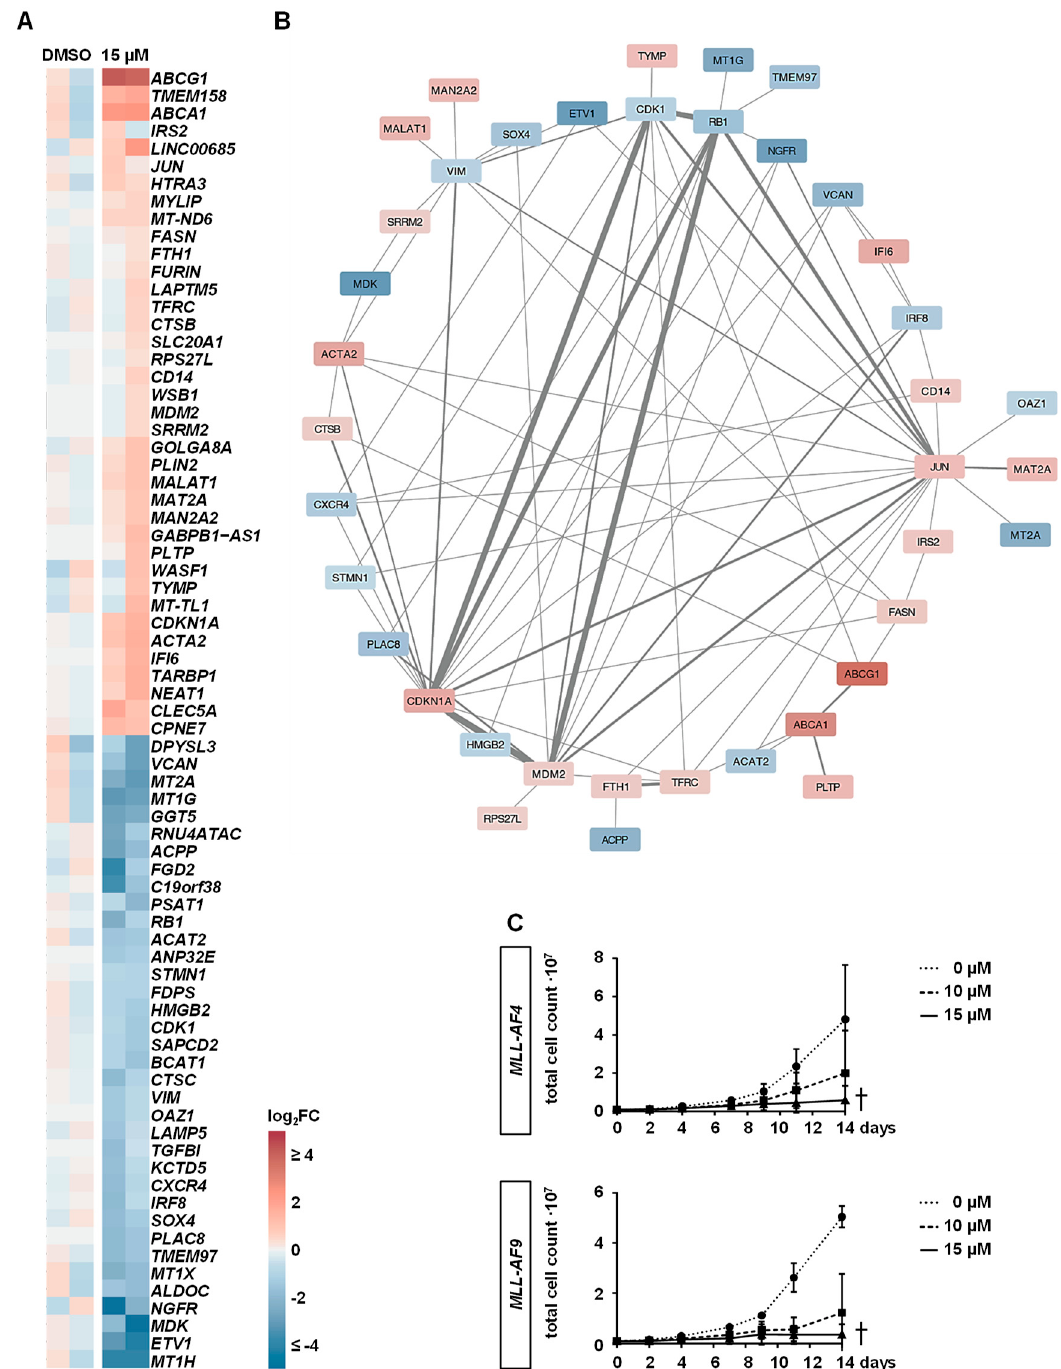
Figure 5. Downstream effects of MAT2A inhibition on gene expression. ( A ) MLL-AF4 cells were treated with 15 µM of PF-9366 or vehicle (DMSO) for 4 days and two biological replicates ( n = 2) were used for RNA-seq. DEGs are displayed with 38 genes upregulated and 36 genes downregulated. The interactome of all DEGs is shown in ( B ) with the main effect of MAT2A inhibition on cell cycle progression notable by the interacting genes CDKN1A/p21 , CDK1 , RB1 , and MDM2. ( C ) For long-term experiments, MLL-AF4/-AF9 cells were treated with 10 or 15 µM of PF-9366 or vehicle (DMSO) for a minimum of 2 weeks. Stable inhibition of proliferation is shown by two biological replicates ( n = 2) performed in technical triplicates.